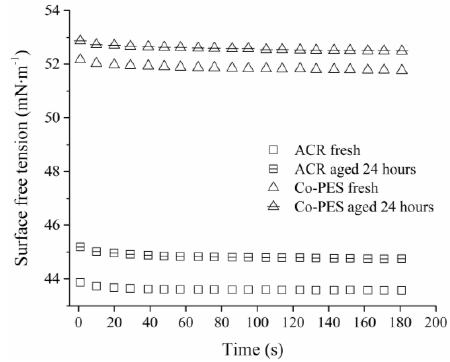
Figure 1. Surface tension time dependence of ACR and Co-PES dispersions; fresh and aged for 24 h at 40 °C.